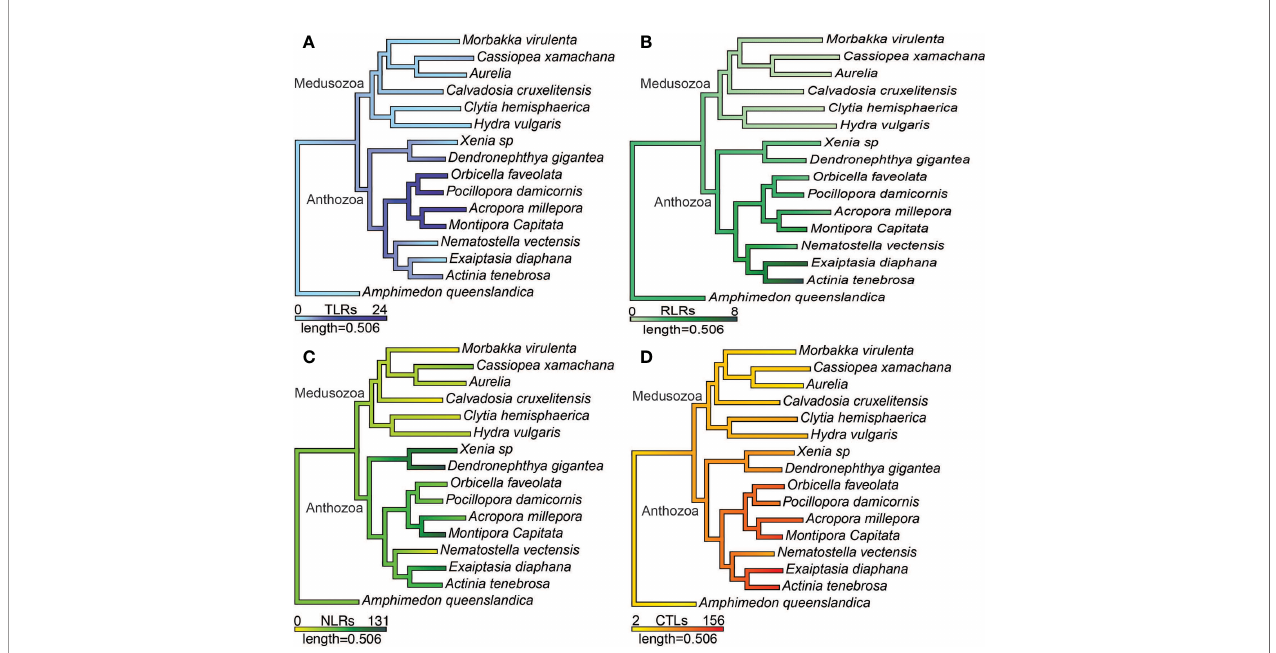
FIGURE 3 | Ancestral state reconstructions of the number of (A) prototypical TLRs and TLR-like proteins, (B) RIG-I/MDA5-like receptors and LGP2-like receptors (C) prototypical NLRs and NLR-like proteins (D) CTLs.